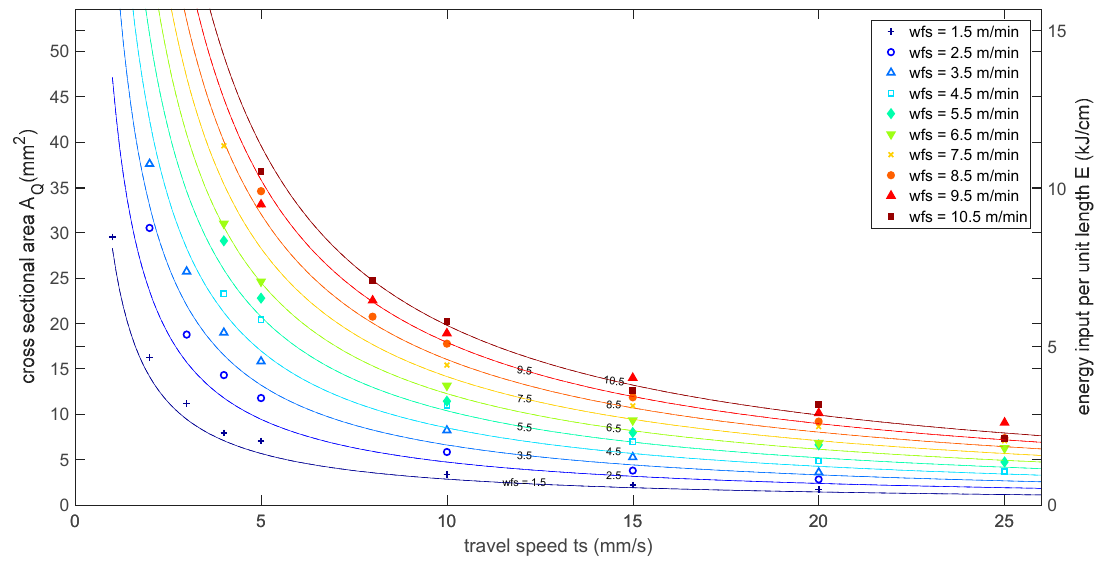
Figure 3. Theoretical influence of travel speed and wire feed speed on energy input per unit length and cross-sectional area of the single weld bead (solid lines) in comparison with cross-sectional area of weld trials (markers).